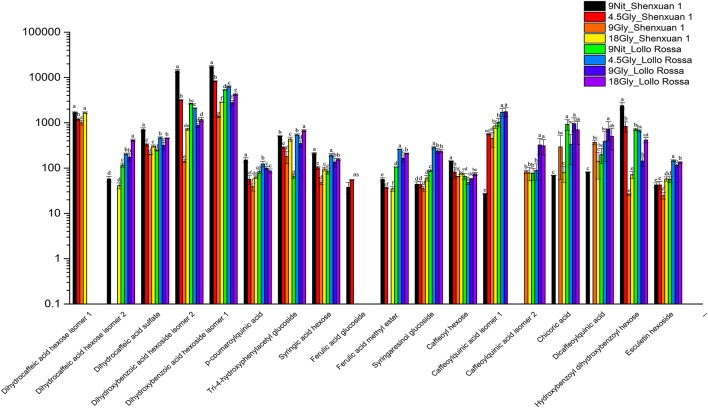
Effects of nitrate and glycine supply on the relative ratios of phenolic acid derivatives in lettuce leaf extracts. Different small letters indicate significant differences (p < 0.05) and “ns” indicates non-significant differences (p ≥ 0.05; LSD analysis, n = 3).